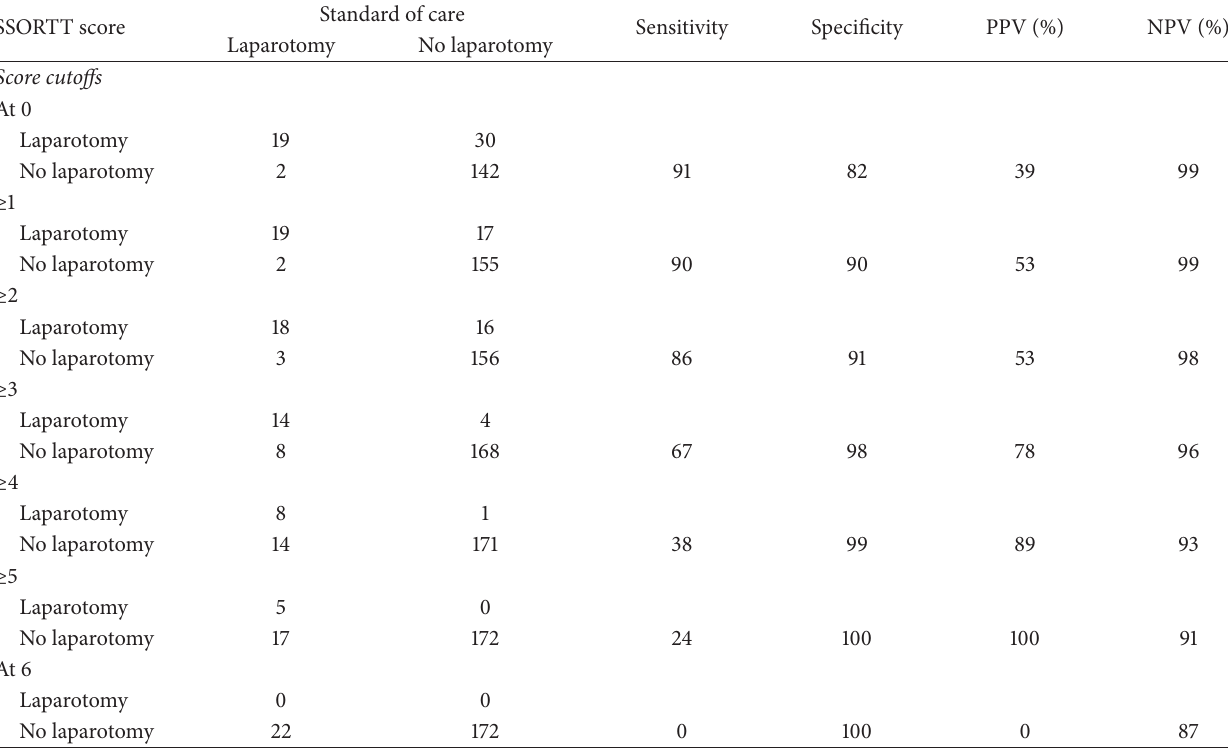
Table 2: Laparotomy predictions at selected cutoffs.